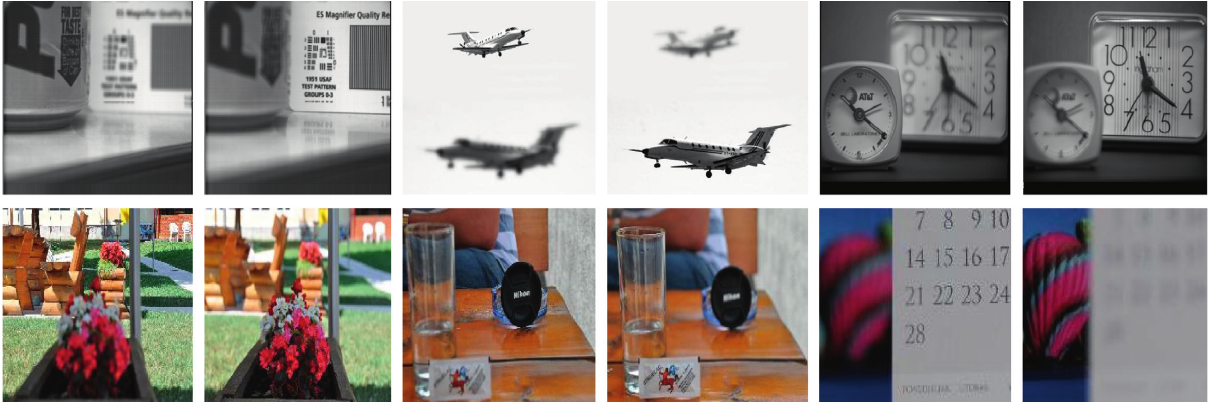
Figure 5: Parts of the source images in experiments.